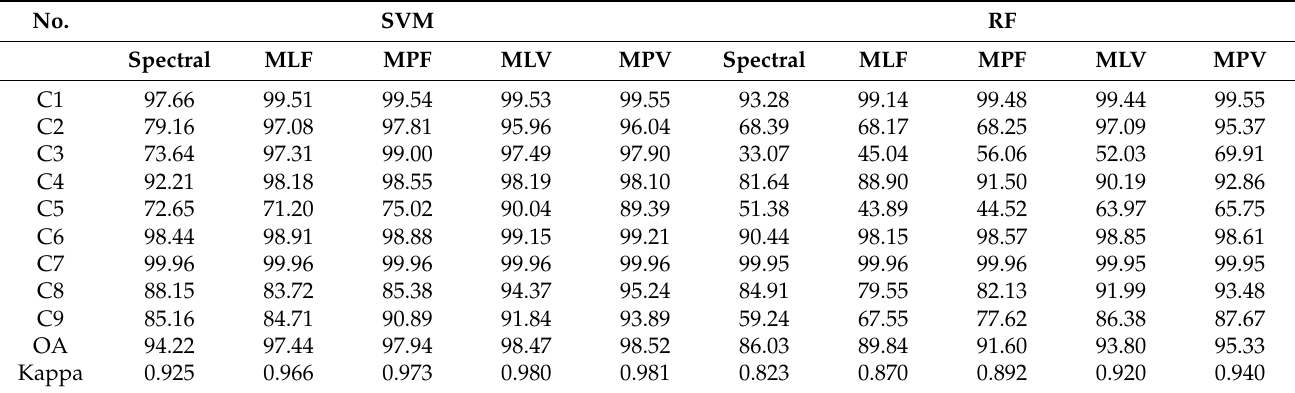
Table 10. Classification accuracies given by different methods for the Longkou dataset using SVM and RF with 100 training samples per class.